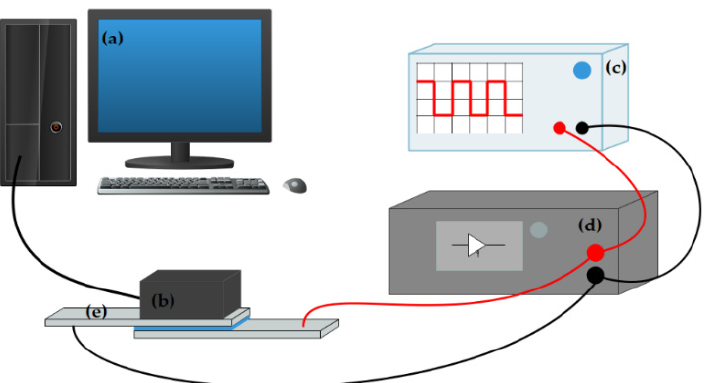
Figure 3. An experimental platform of the electrophoretic display (EPD) cell. The experimental platform consists of a computer ( a ), a colorimeter ( b ), a function generator ( c ), a voltage amplifier ( d ), and an EPD cell ( e ).